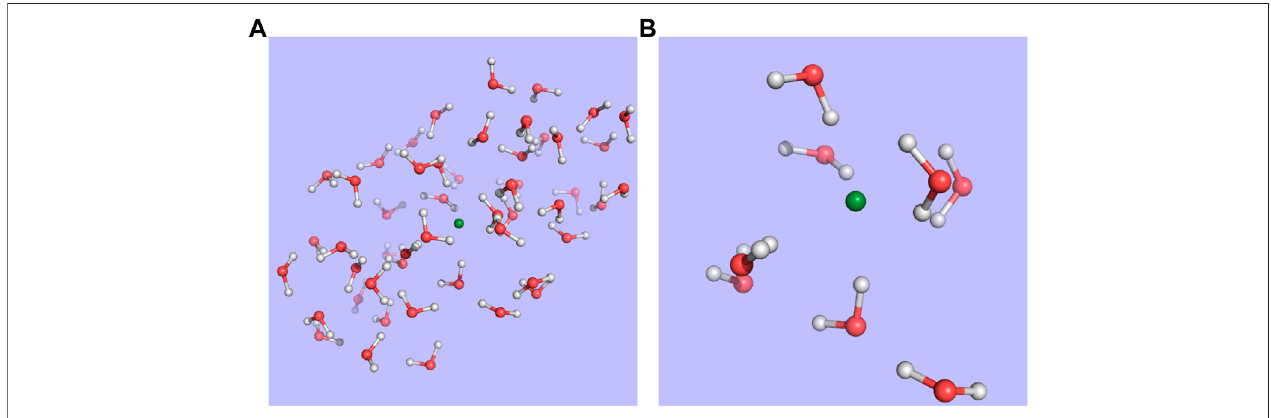
FIGURE 1 | Structure for snapshot 1 of the fl uoride-water droplet system taken from Bouchafra et al. (Bouchafra et al., 2018a; Bouchafra et al., 2018b) (A) and the model used in this work (B) , in which the halide and the eight nearest water molecules making up its fi rst solvation shell were extracted from the 50-water droplet.